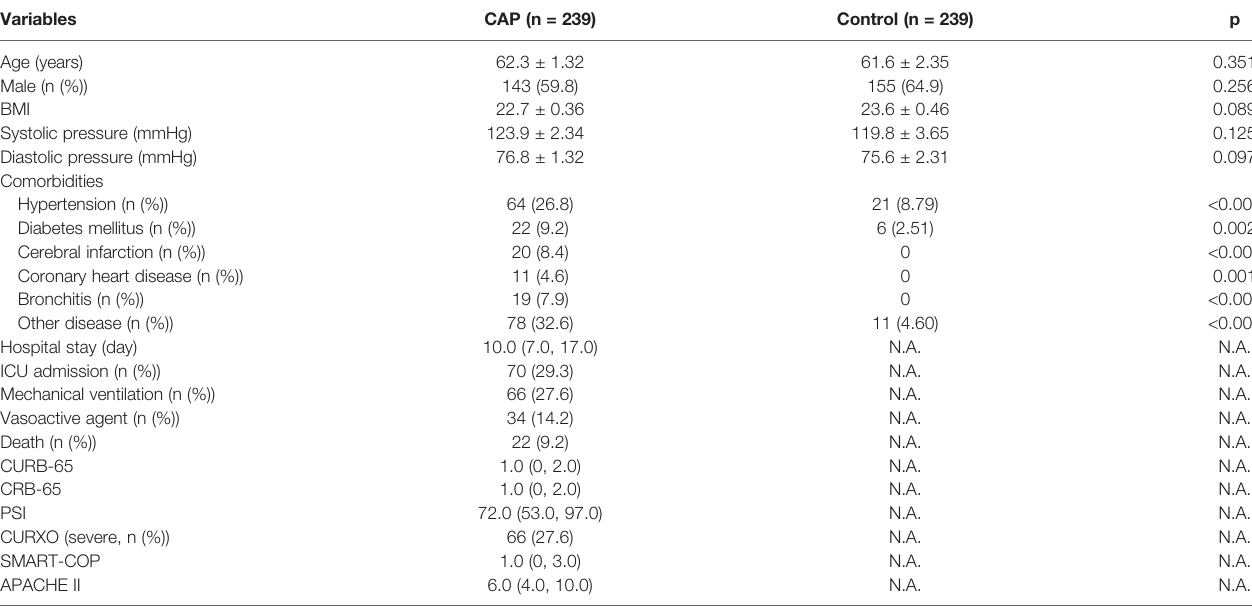
TABLE 1 | Demographic characteristics of participators at